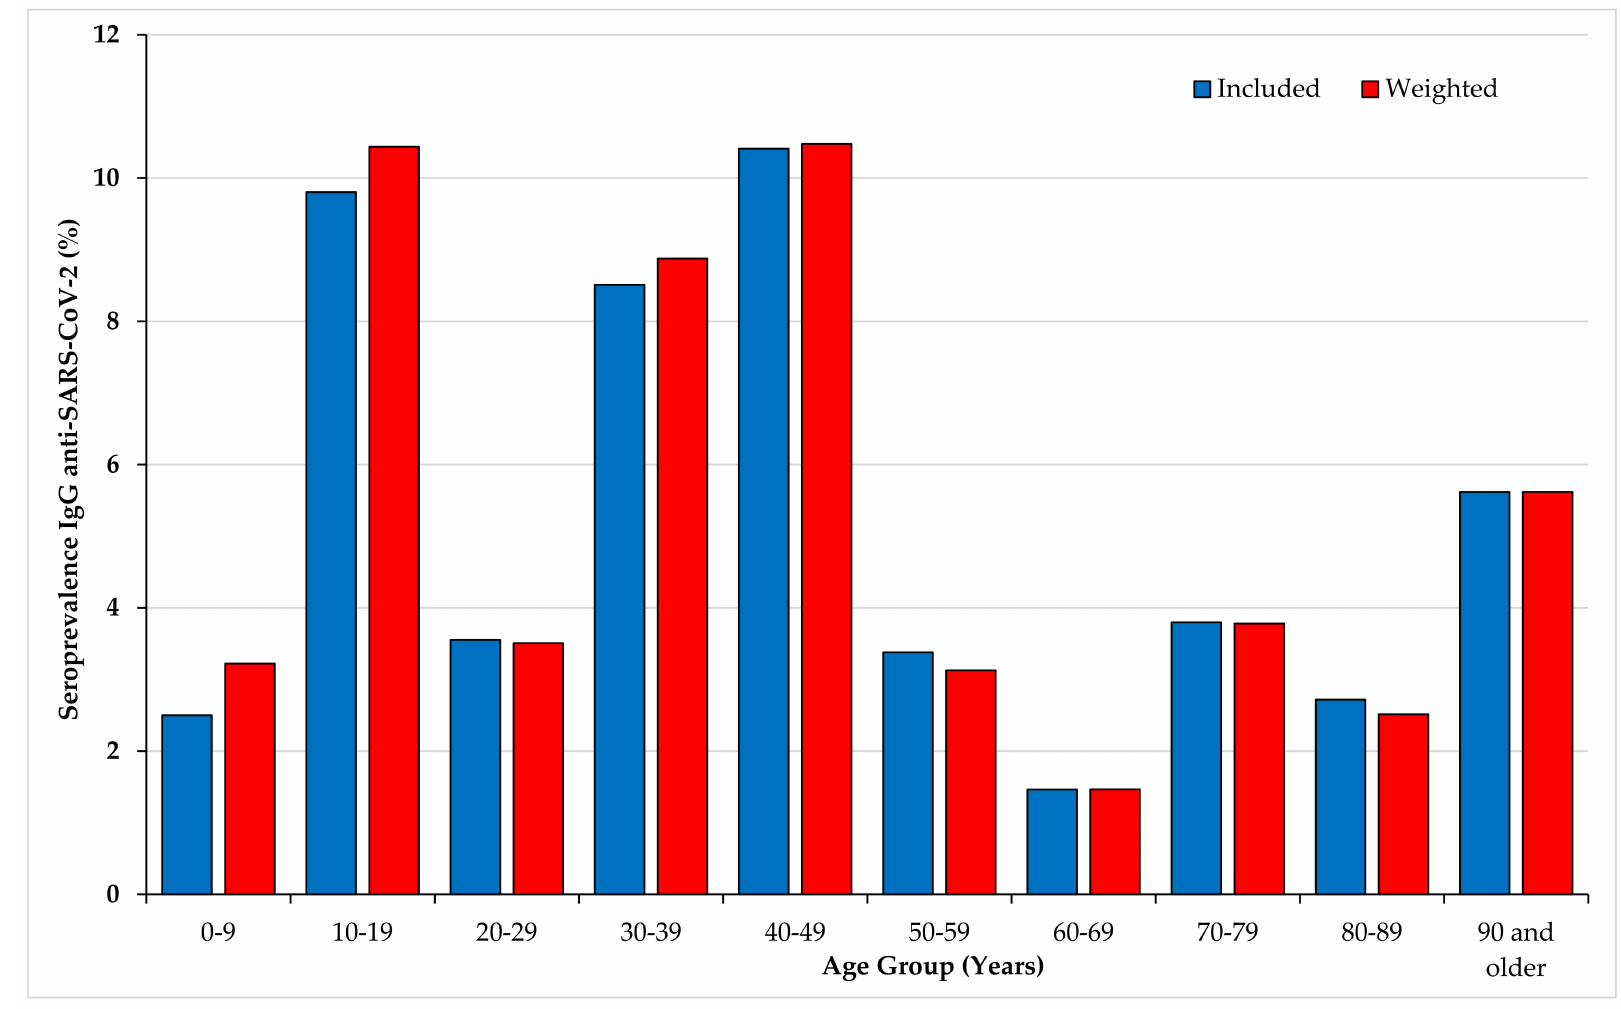
Figure 2. Seroprevalences of IgG anti-SARS-CoV-2 by age groups (included and weighted population). IgG: Immunoglobulin G; SARS-CoV-2: severe acute respiratory syndrome